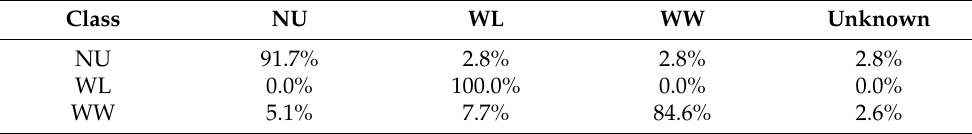
Table 1. The confusion matrix corresponding to the trained neural network model, created by classifying 100 water consumption episodes, of specific (and known) type